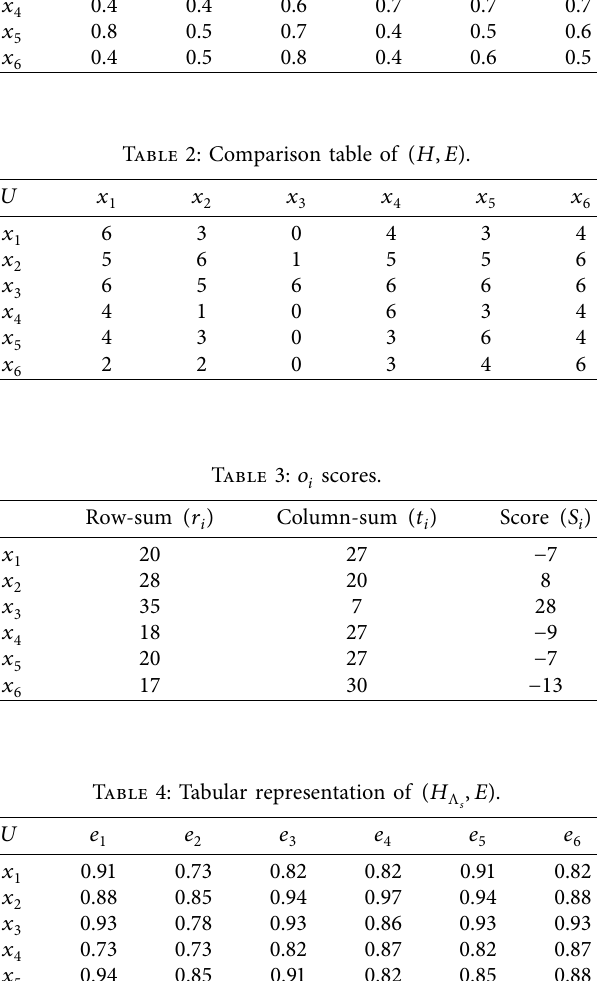
Table 9: Tabular representation of Λ